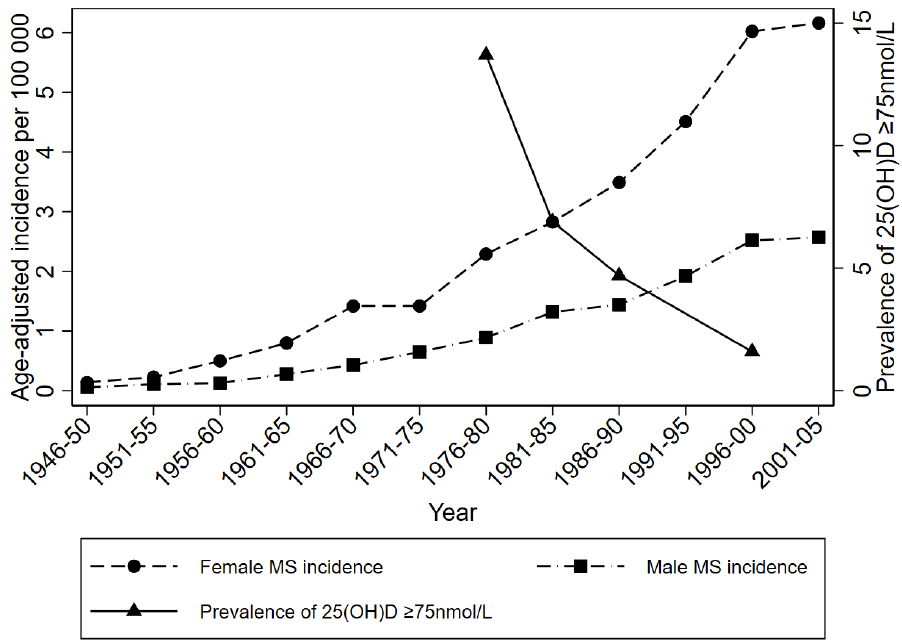
Figure 4. Data from Sweden on age-adjusted incidence (per 100,000 person years) of MS overlaid with the prevalence of 25(OH)D level ≥75nmol/L (plotted from data available in [24] and [25]) in time periods from 1946–2005.